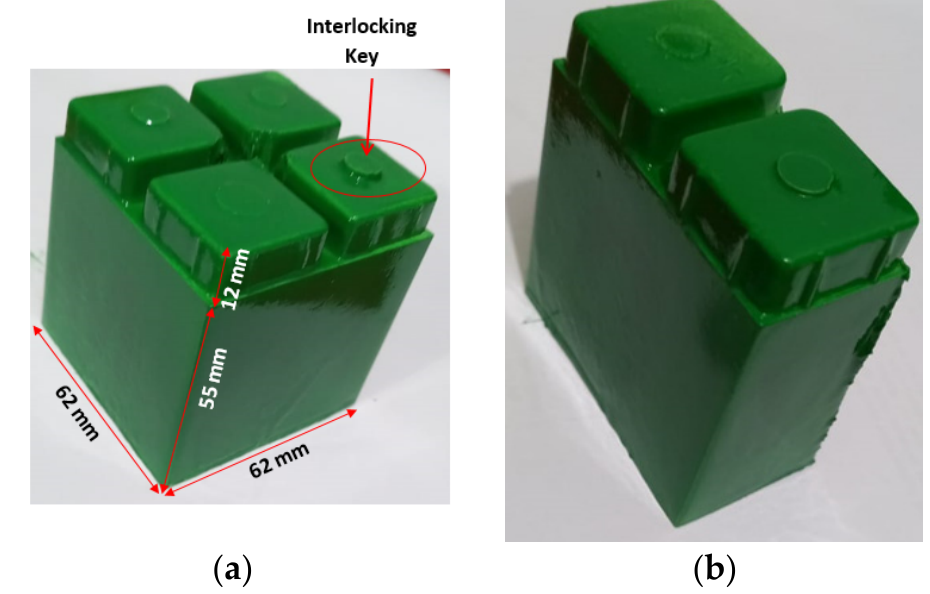
Figure 3. Scaled-down interlocking plastic stretcher block and half block for the current study. ( a ) Stretcher block. ( b ) Half block.